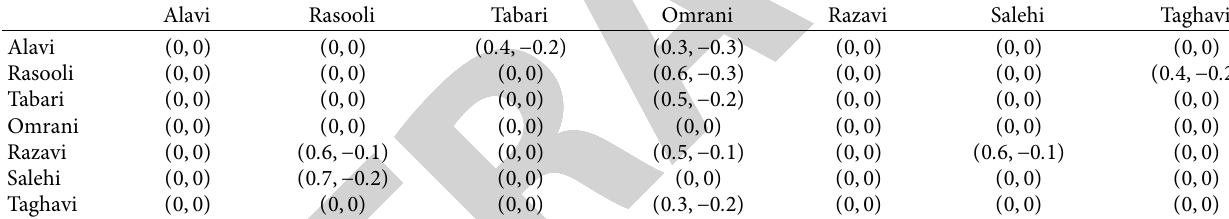
Table 4: Adjacency matrix corresponding to Figure 3.